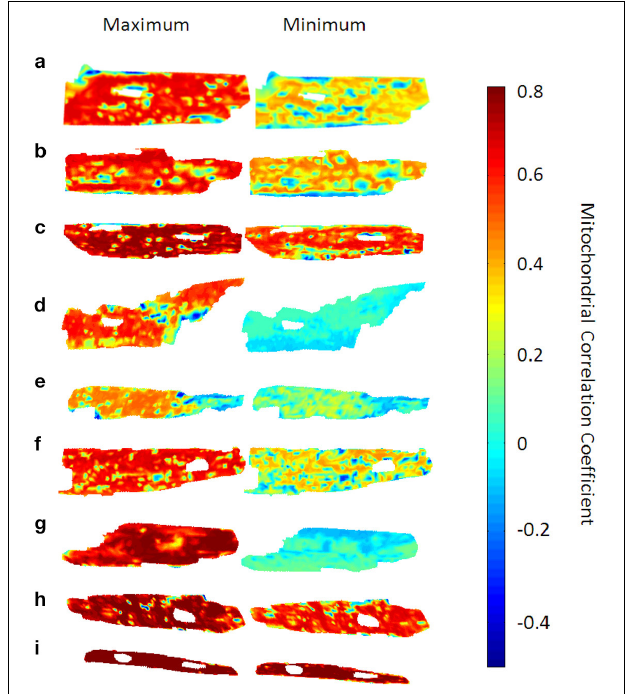
FIGURE 2 | Time-dependent mitochondrial “mean field” correlation maps for 9 cardiac myocytes. The left hand side shows the correlation maps at the time point with the highest network mean correlation c ( t ) (see main text), whereas the right hand side shows those maps at the time point with the lowest mean correlation. Mitochondrial mean correlation values range between − 0.4 and 0.8, the time-averaged mean correlation coefficient was found to be 0.43 ± 0.07. Also, some myocytes [myocytes (d) and (g)] show a prominent difference in overall correlation, while myocyte (i) does not show too pronounced correlation